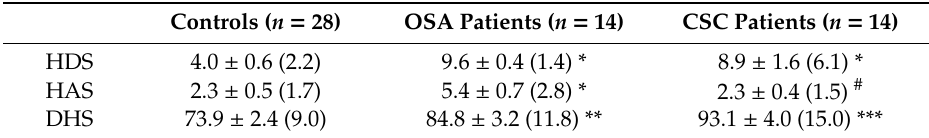
Table 1. Psychological profile in the study populations.